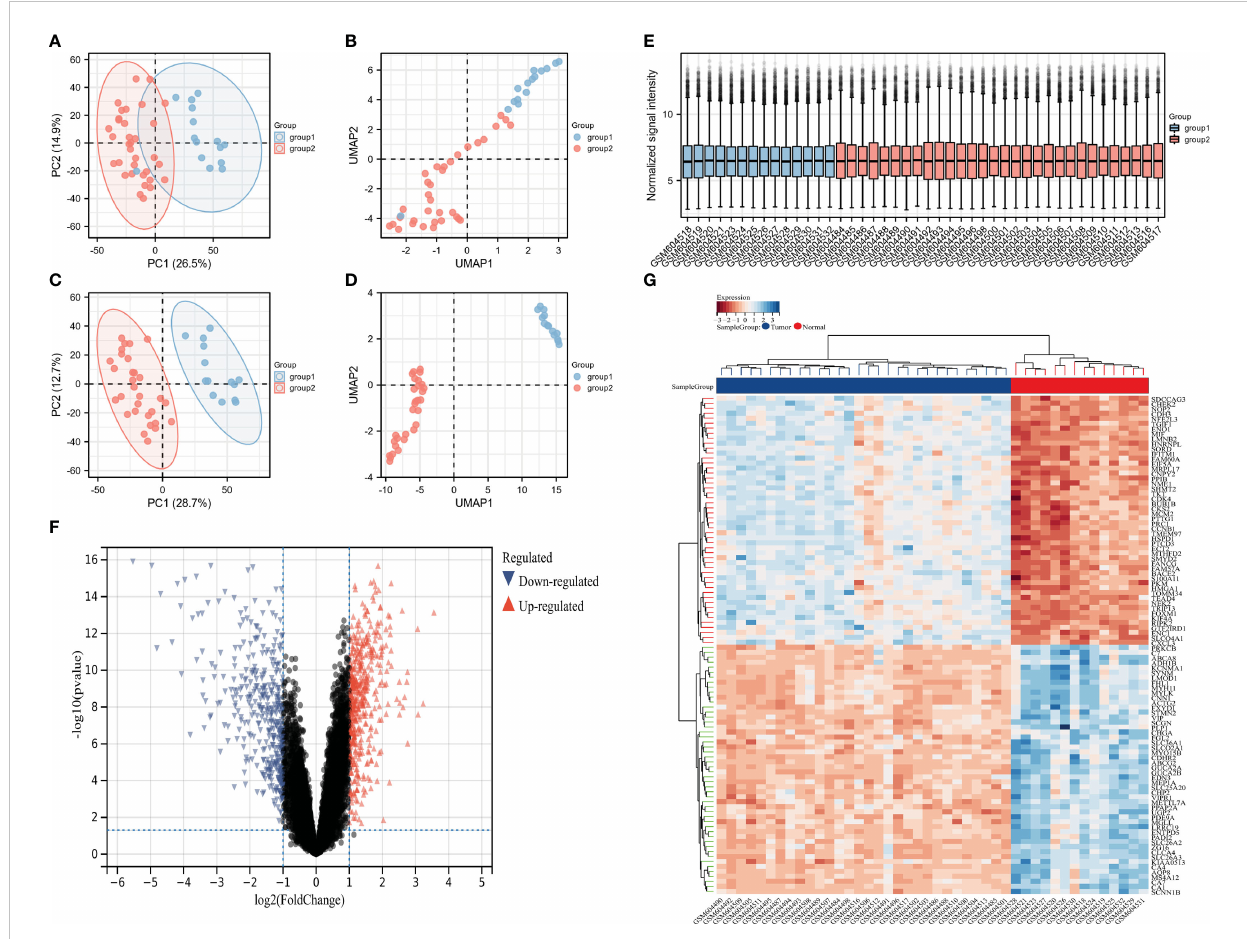
(Figure 4A) in the GSE166555 dataset through dimensionality reduction and clustering. The punctiform fi gures show the cell marker for cell annotation and their expression levels (Figure